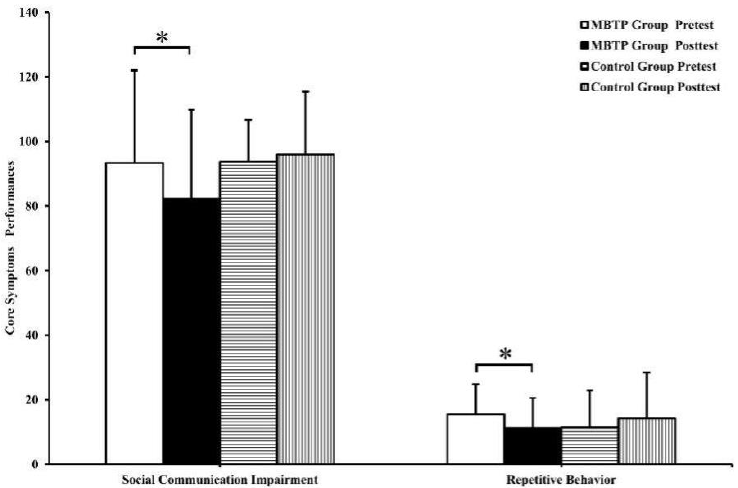
Figure 3. Performances for core symptoms (mean and standard deviation) of time point (baseline versus post-test) and group (MBTP versus control), * p < 0.05.